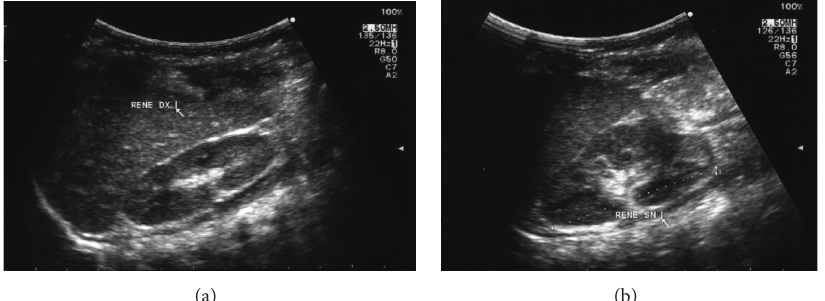
Figure 2: Renal ultrasound: absence of hydronephrosis was showed during a complete abdomen US examination; (a) right kidney and (b) left